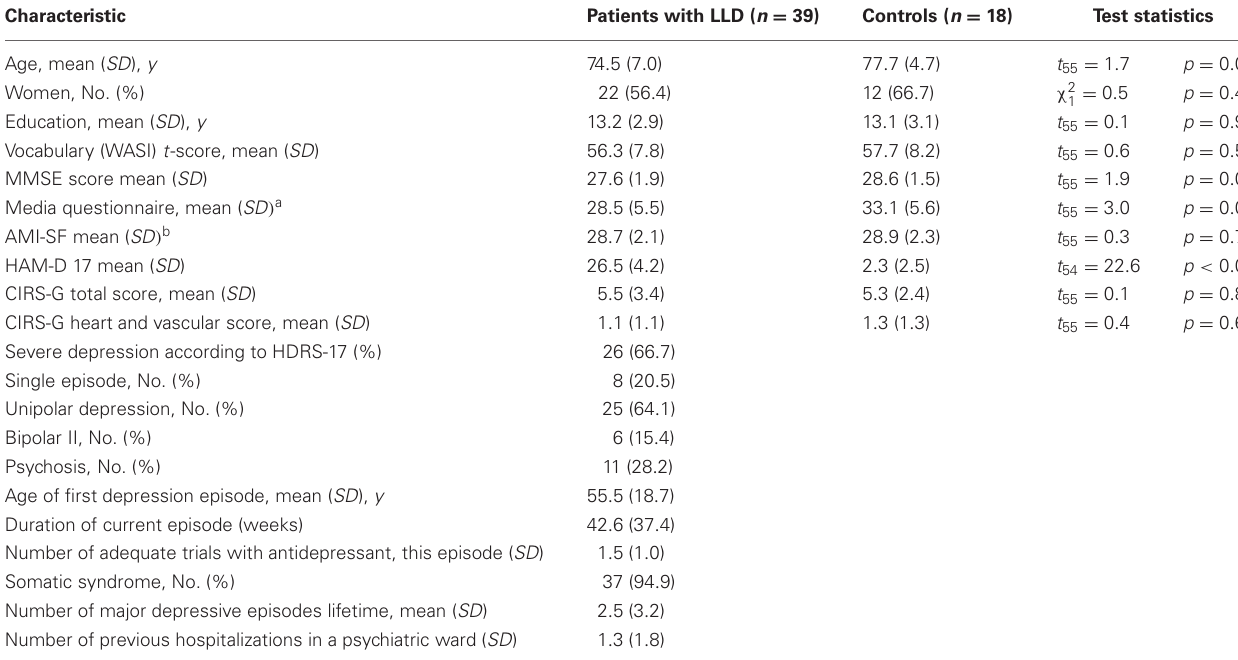
Table 1 | Characteristics of the study